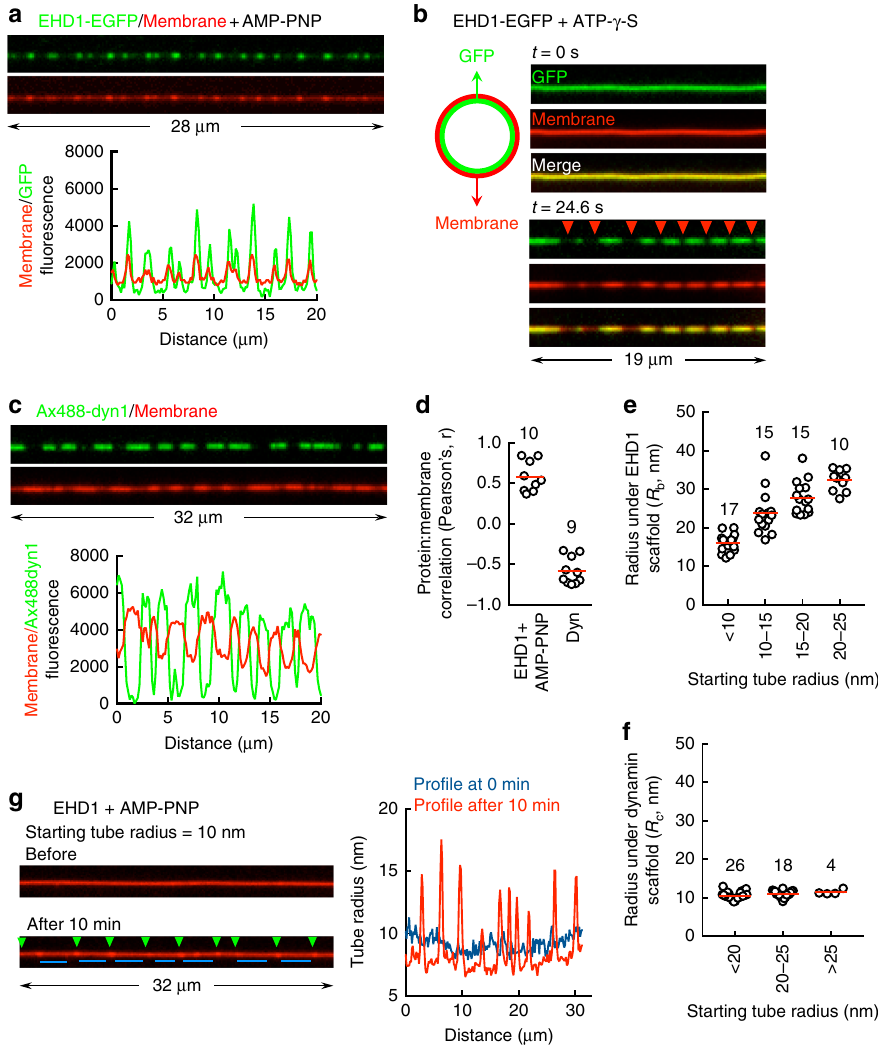
Fig. 5 Membrane remodeling by EHD1. a Representative images and fl uorescence line pro fi les of tubes showing scaffolds of AMP-PNP-bound EHD1-EGFP. b Representative images showing coincidence between GFP and membrane fl uorescence in response to formation of extended EHD1 scaffolds with ATP- γ - S. Red arrowheads mark sites of tube thinning. c Representative images and fl uorescence line pro fi les of tubes showing Alexa488-labeled dynamin1 scaffolds. d Pearson ’ s correlation between protein and membrane fl uorescence for the indicated numbers of tubes. Red lines denote means. e Bulged tube radius ( R b ) under AMP-PNP-bound EHD1 scaffolds as a function of the starting tube radius for the indicated numbers of tubes. Red lines denote means. f Constricted tube radius ( R c ) under dynamin scaffolds as a function of the starting tube radius for the indicated numbers of tubes. Red line denotes means. g Representative images and associated line pro fi les acquired in the membrane channel showing remodeling of a tube by AMP-PNP-bound EHD1 scaffolds. Green arrowheads mark bulged regions and blue lines mark thinned-down regions on the